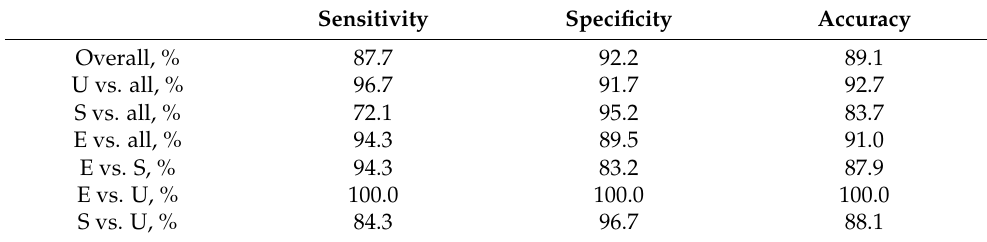
Table 2. CNN performance for detection and differentiation of small-bowel preparation